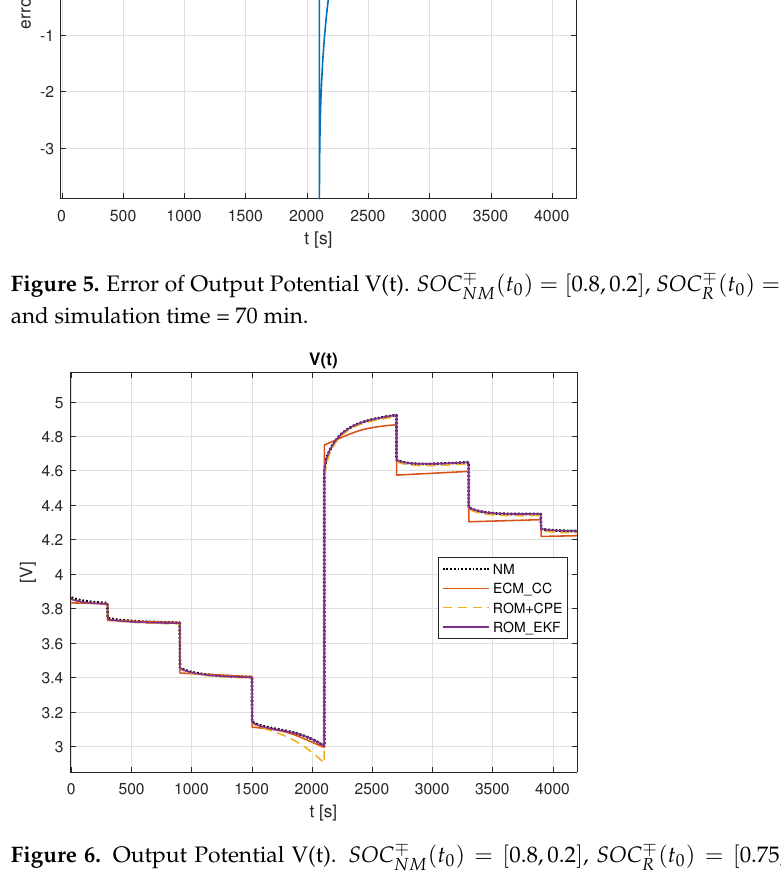
Figure 6. Output Potential V(t). SOC ∓ simulation time = 70